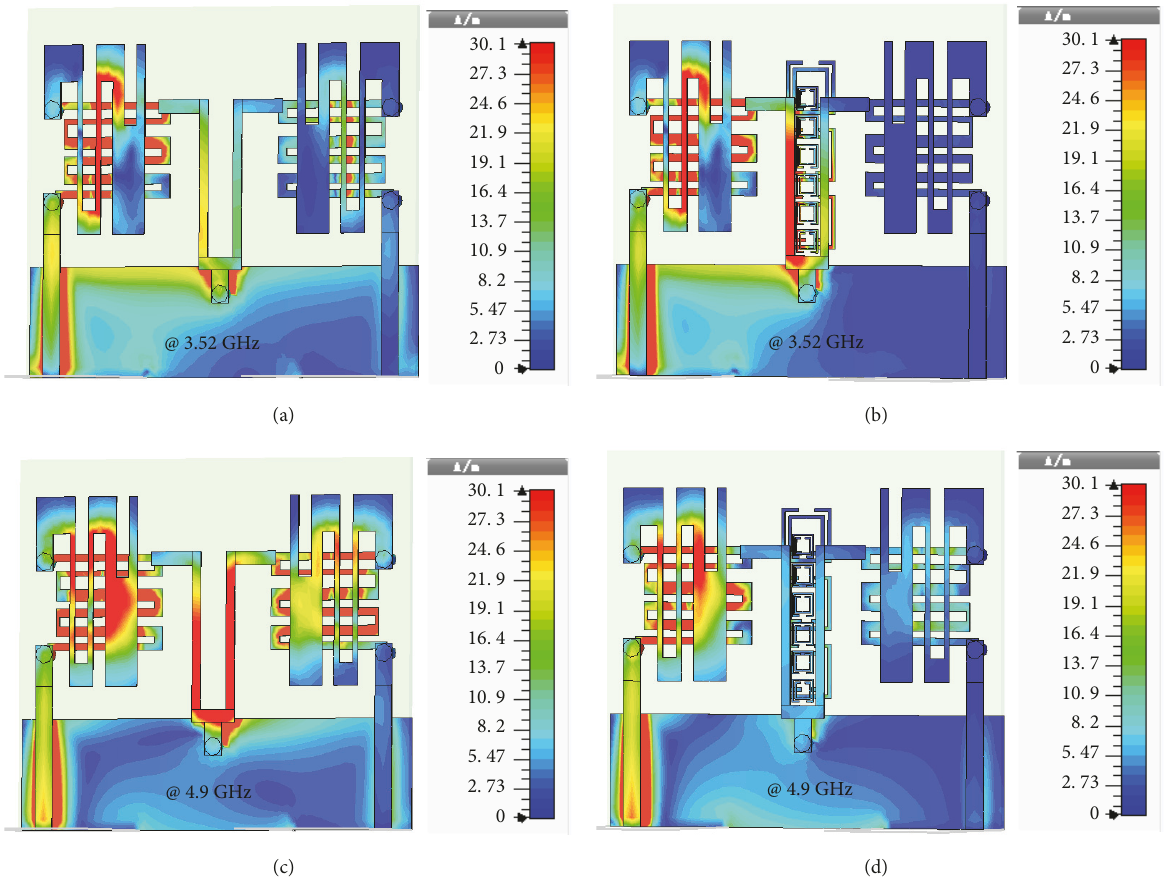
Figure 9: Surface current. (a) Original antenna and (b) improved antenna at 3.52 GHz; (c) original antenna and (d) improved antenna at 4.9 GHz.